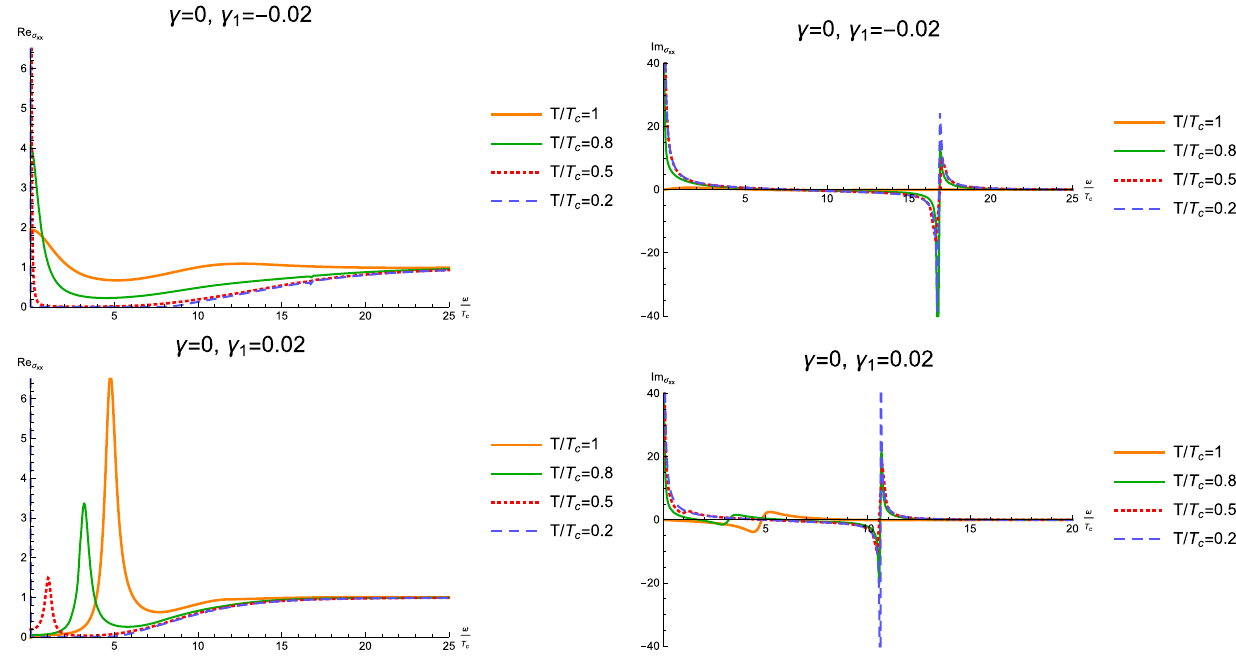
Fig. 5 The conductivities σ xx as a function of the frequency for different γ 1 . The left panels are for the real part and the right panels are for the imaginary one